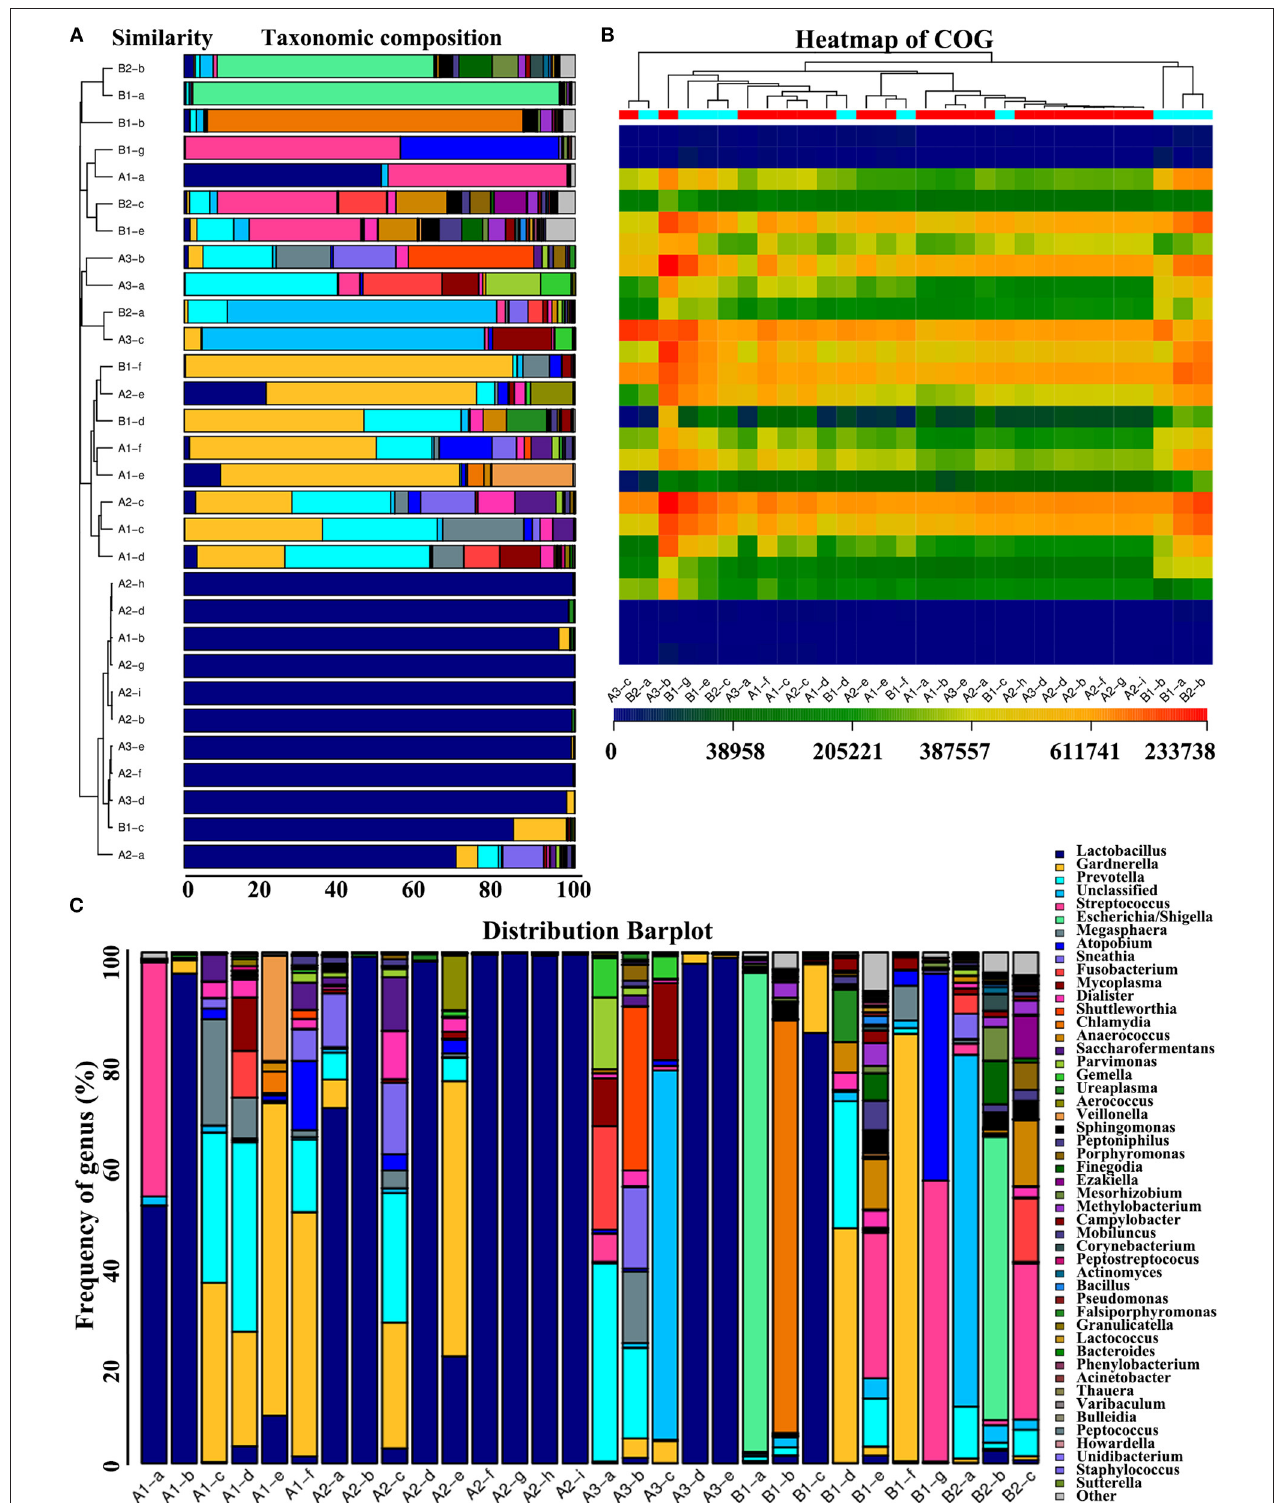
FIGURE 5 | Community taxonomy system at the genus level and COG-based functional structure distribution. (A) Taxonomic composition distribution graph showing the relative sample microorganism classification abundance. The horizontal or vertical axis is the sample number or relative abundance ratio. The width of different colors indicates the relative abundance ratio of different species at the taxonomic level. Left panel: Bray-Curtis-based sample clustering tree diagram; middle panel